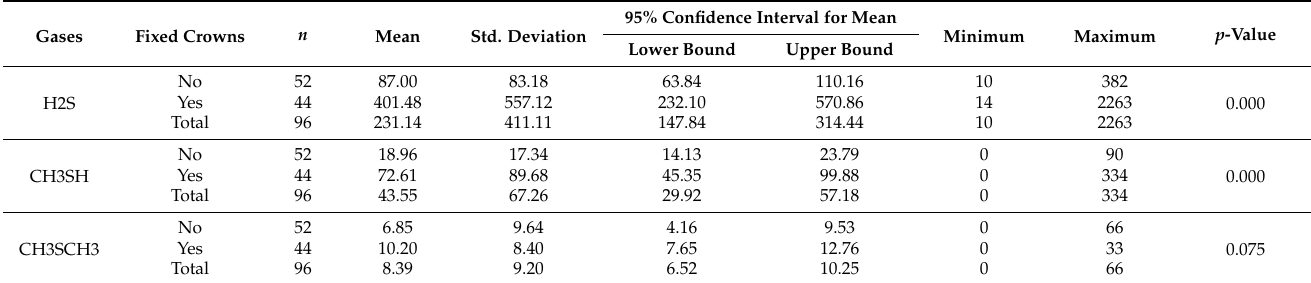
Table 3. Comparison of the concentration of volatile sulphur compound gases (VSCs) in participants with or without fixed crowns ( n = 96).